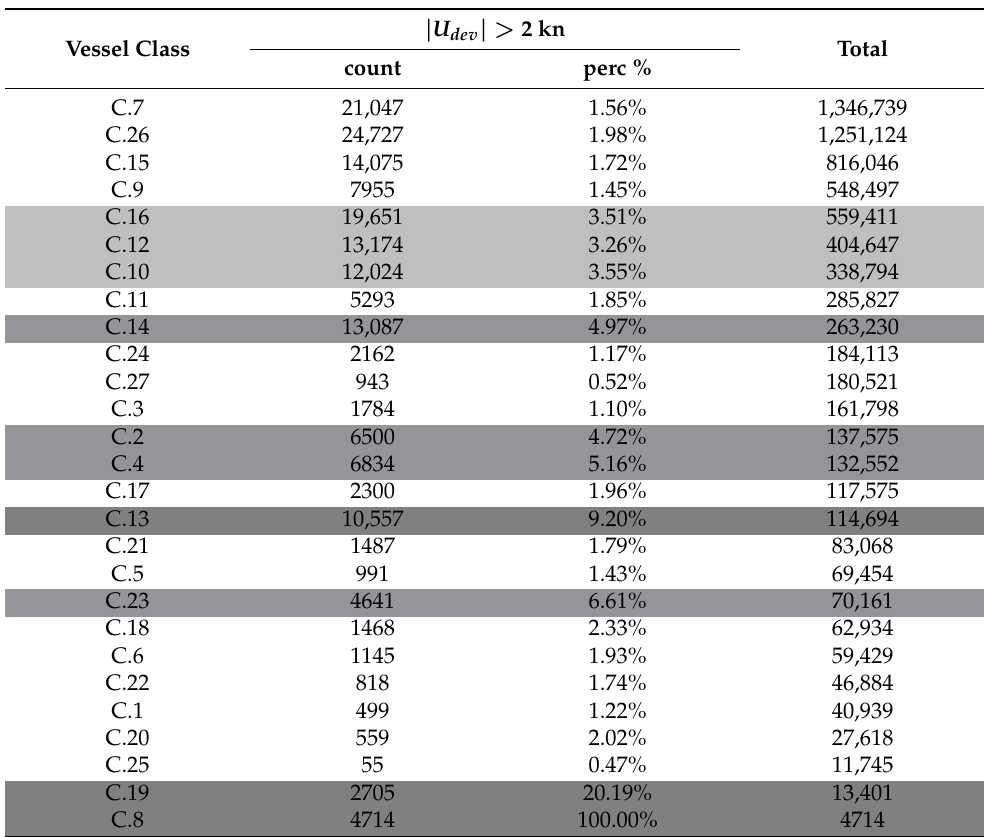
Table 11. Speed deviation U dev above 2 knots boundary decomposed by vessel class. Gray back- ground shows up when | U dev | > 2 kn percentage column is greater than 2.47% and it gets darker while it